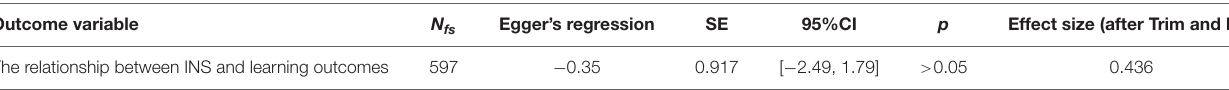
TABLE 2 | Publication bias